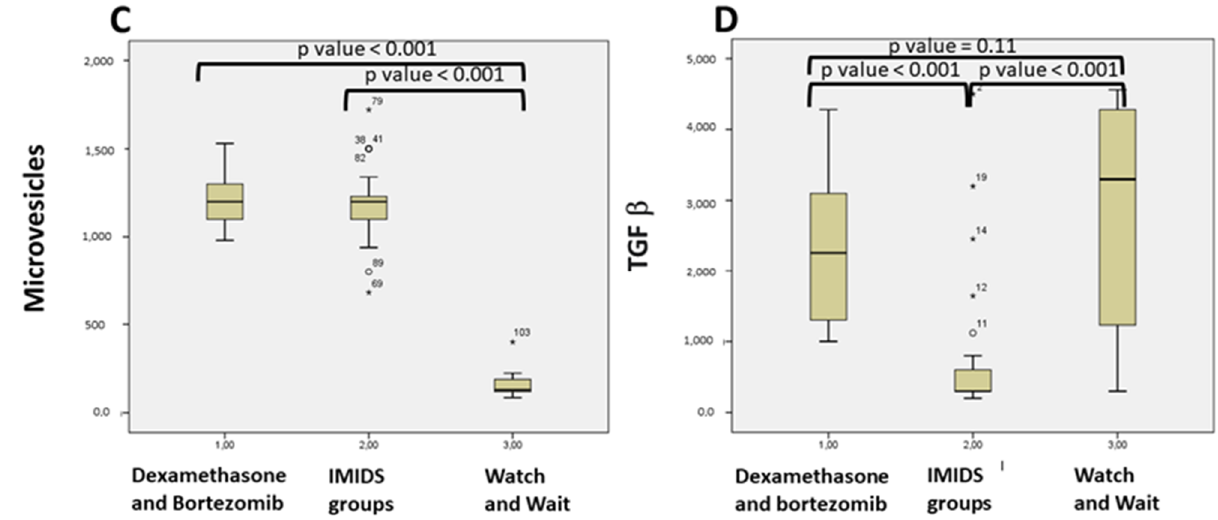
Figure 3. Comparison of patients based on different treatment: ( A ) IL-17 levels in Dexamethasone and Bortezomib; IMiDs based treatment; Watch and Wait Smoldering MM patients; ( B ) Glomerular Filtration Rate levels in Dexamethasone and Bortezomib; IMiDs based treatment; Watch and Wait Smoldering MM patients ( C ) Microvesicles in Dexamethasone and Bortezomib; IMiDs based treatment; Watch and Wait Smoldering MM patients ( D ) TGF-β in Dexamethasone and Bortezomib; IMiDs based treatment; Watch and Wait Smoldering MM patients.